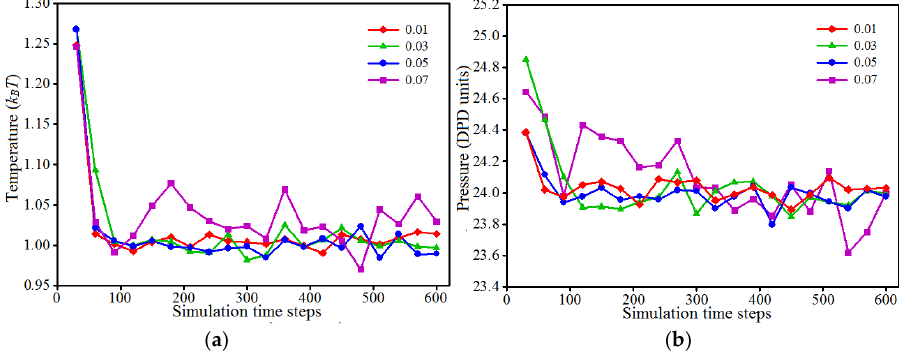
Figure 2. Simulated temperature ( a ) and pressure ( b ) for the 10% PVA/10% PAM/2% nano-silica blended hydrogel system with different time steps; DPD: dissipative particle dynamics.